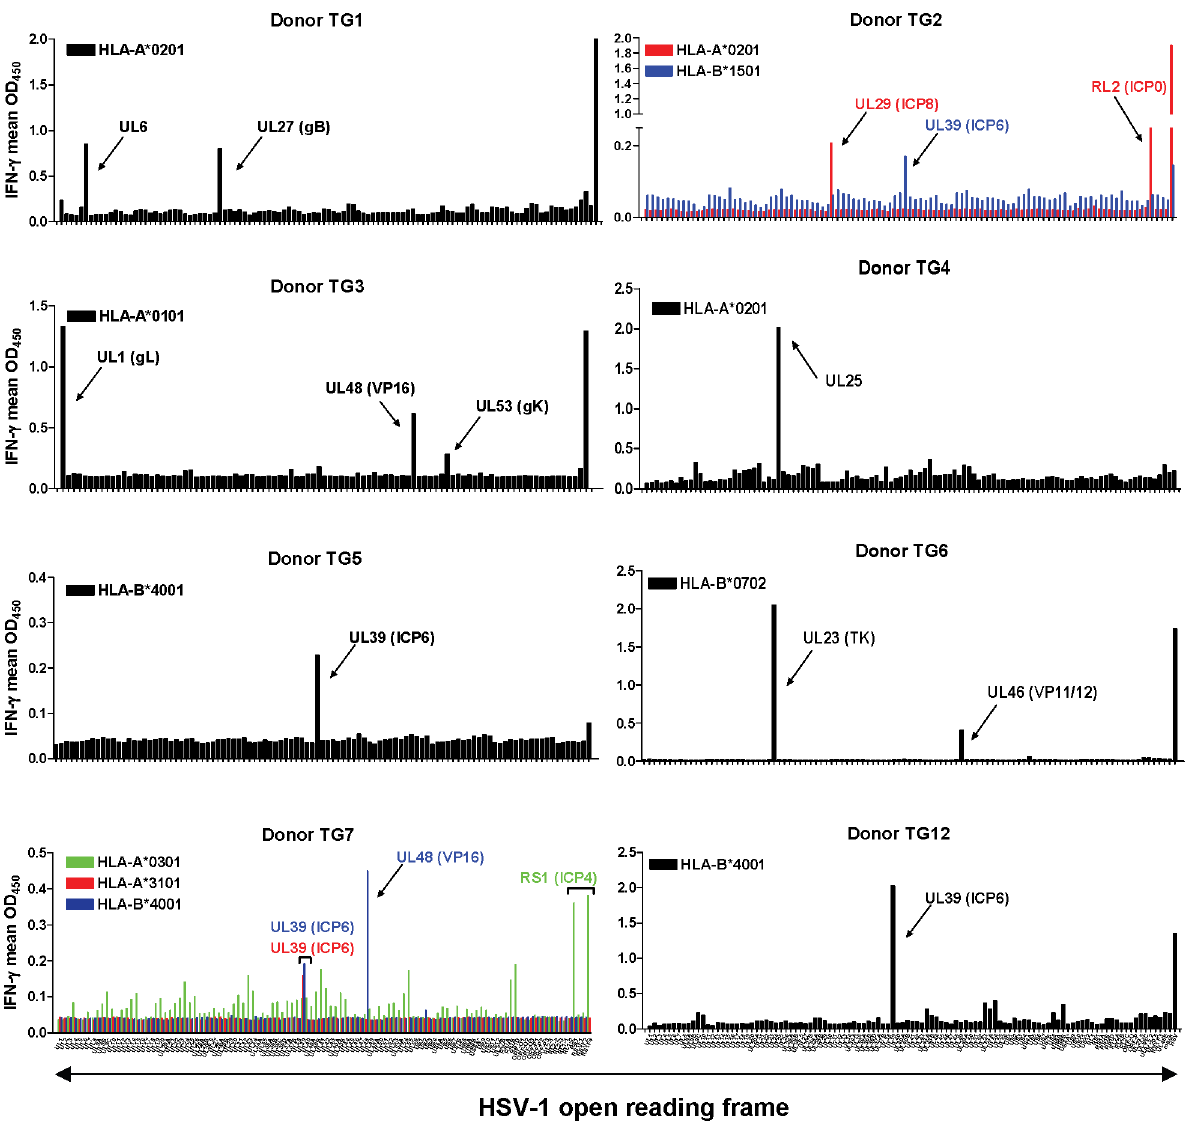
Figure 3. HSV-1 antigens recognized by human TG-derived CD8 T-cells. Representative data from TG-TCL of 6 TG donors assayed for T-cell reactivity to proteins encoded by individual HSV-1 open reading frames (ORFs). Mean IFN- c secretion levels, shown as arbitrary OD 450 values, by TG- TCL exposed in duplicate to Cos-7 cells that co-express the respective donor-specific HLA class I allele and the individual HSV-1 ORFs arrayed in nominal genomic order on the x-axis. The names of the HSV-1 ORFs and corresponding proteins specifically recognized are indicated by an arrow. The HSV-1 ORFs recognized by the TG-TCL of donors TG2 and TG7 are shown in colors of the respective TG donor-specific HLA class I allele. ICP, infected cell polypeptide; VP, virion protein and in case of a viral glycoprotein (e.g. gB, glycoprotein B). Currently, no proteins names are available for HSV-1 ORFs UL6 and UL25 .